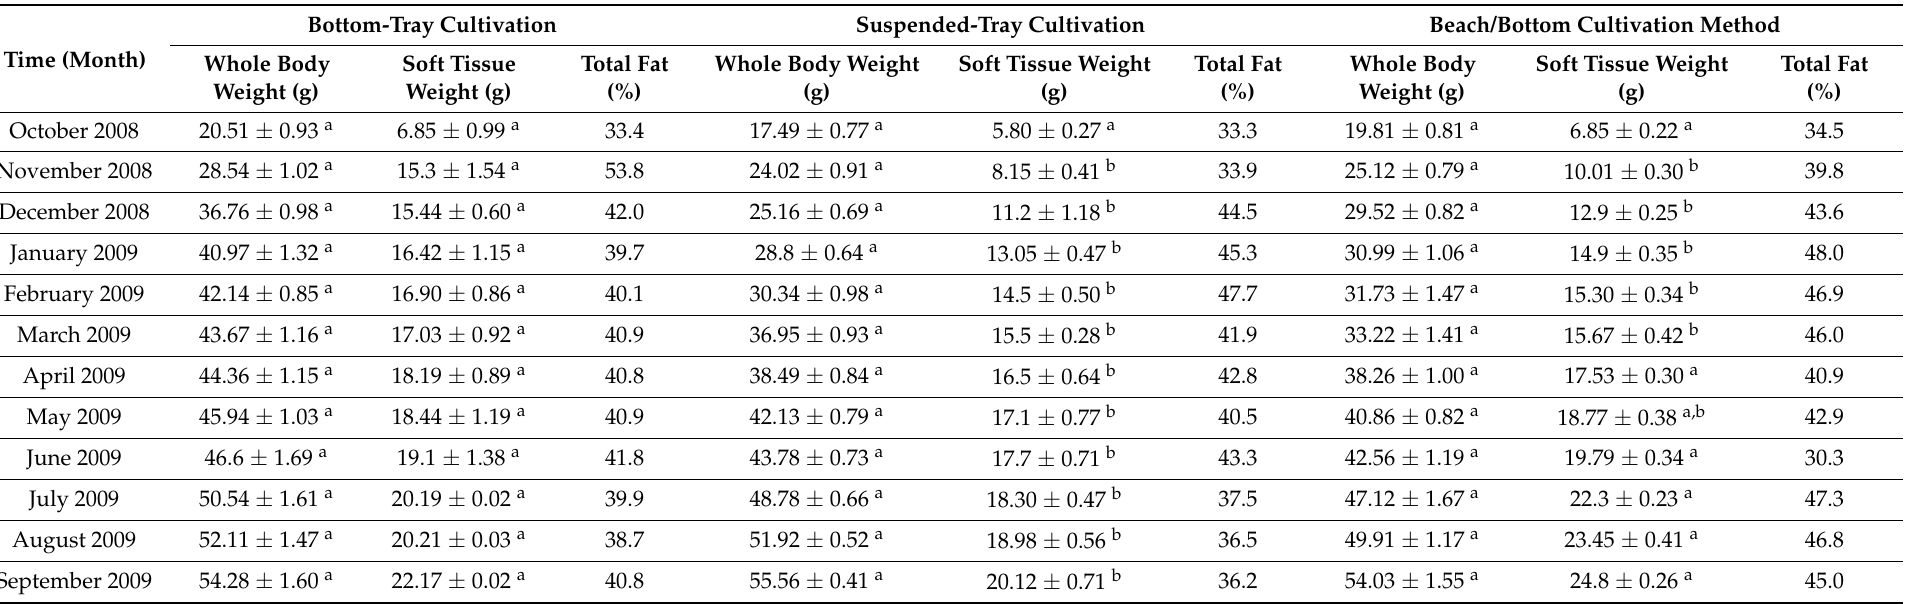
Table 1. Body weight, soft tissue weight, and fatness of snout otter clams in three different methods of growing. Bottom-Tray